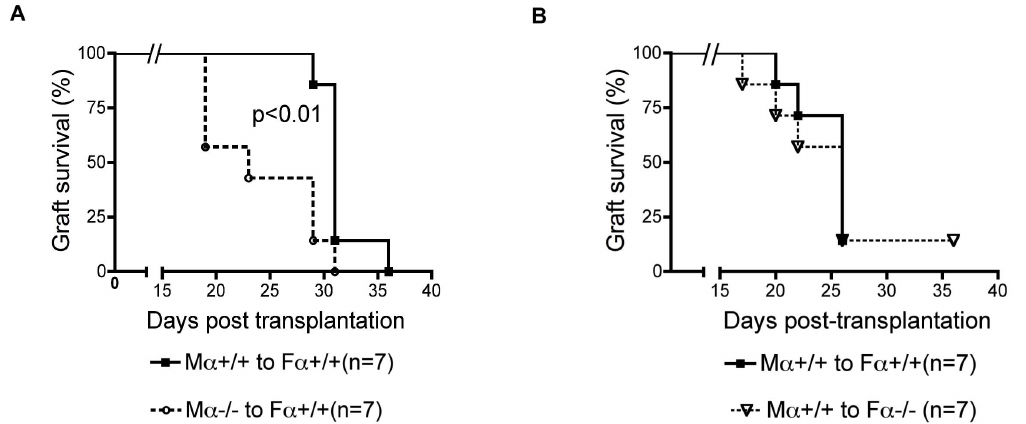
Figure 4. Comparison of selective a 7nAChR deficiencies in donors or recipients. ( A ): a 7 + / + wild type female mice were grafted with either a 7 + / + or a 7 2 / 2 male skin grafts. Imiquimod was applied from day 10 to day 15 after transplantation. Graft survival is compared. ( B ): Graft survival of male a 7 + / + skin grafts on either a 7 + / + or a 7 2 / 2 female recipients treated with imiquimod from days 10 to 15.